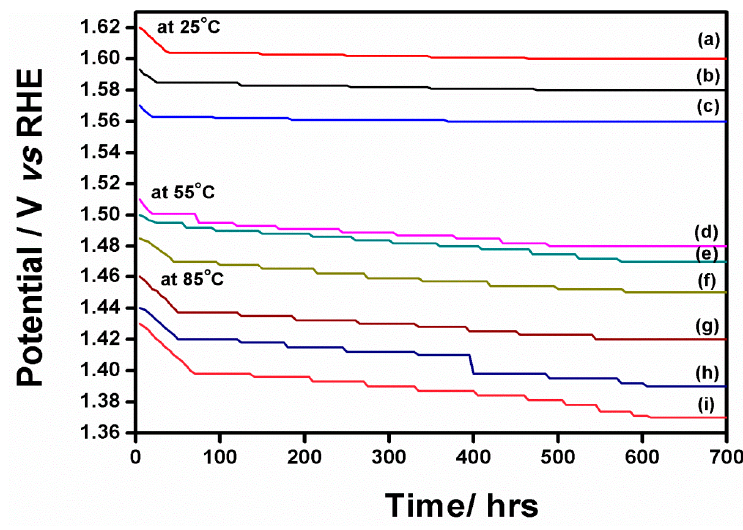
Figure 8. Chronopotentiometry measurement of ( a ) Ni on TC, ( b ) Fe on TC, and ( c ) NiFe-LDH on TC at 25 °C, ( d ) Ni on TC, ( e ) Fe on TC, and ( f ) NiFe-LDH on TC at 55 °C, and ( g ) Ni on TC, ( h ) Fe on TC, and ( i ) NiFe-LDH on TC at 85 °C.